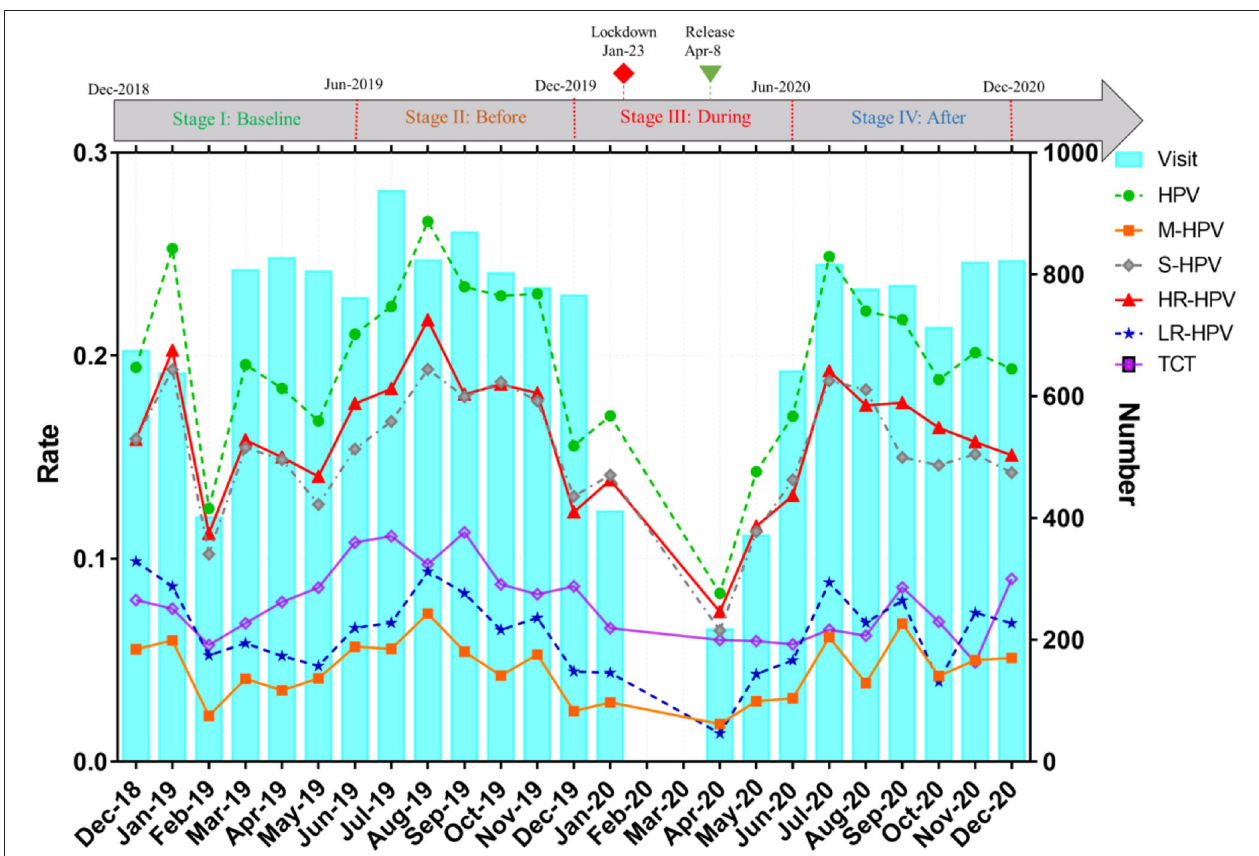
FIGURE 1 | Overall trend of monthly HPV screening visits and infection rates. HPV, human papillomavirus; HR-HPV, high-risk HPV infection; LR-HPV, Low-risk HPV infection; M-HPV, multiple genotype HPV infection; S-HPV, single genotype HPV infection; TCT, ThinPrep cytology test abnormal. (i) Stage I (December 1, 2018–May 31, 2019): Baseline in the same period last year before the SARS-CoV-2 outbreak; (ii) Stage II (June 1, 2019–November 31, 2019): Before SARS-CoV-2 outbreak; (iii) Stage III (December 1, 2019–June 30, 2020): During the prevalence of SARS-CoV-2; (iv) Stage IV (July 1, 2020–December 31, 2020): After the SARS-CoV-2